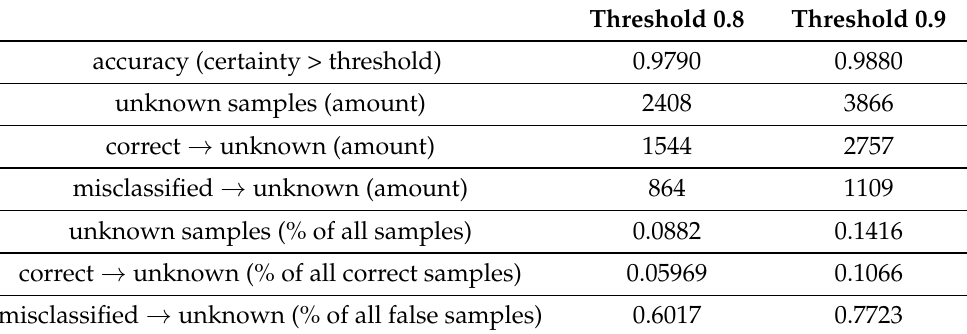
Table 3. The change of accuracy when discarding samples under a chosen certainty is shown. Additionally, the table shows how many samples of the total dataset, the correct classified subset and the misclassified subset are assigned to “unknown” in consideration of the different certainties. The test set consists of the untrained subject not being